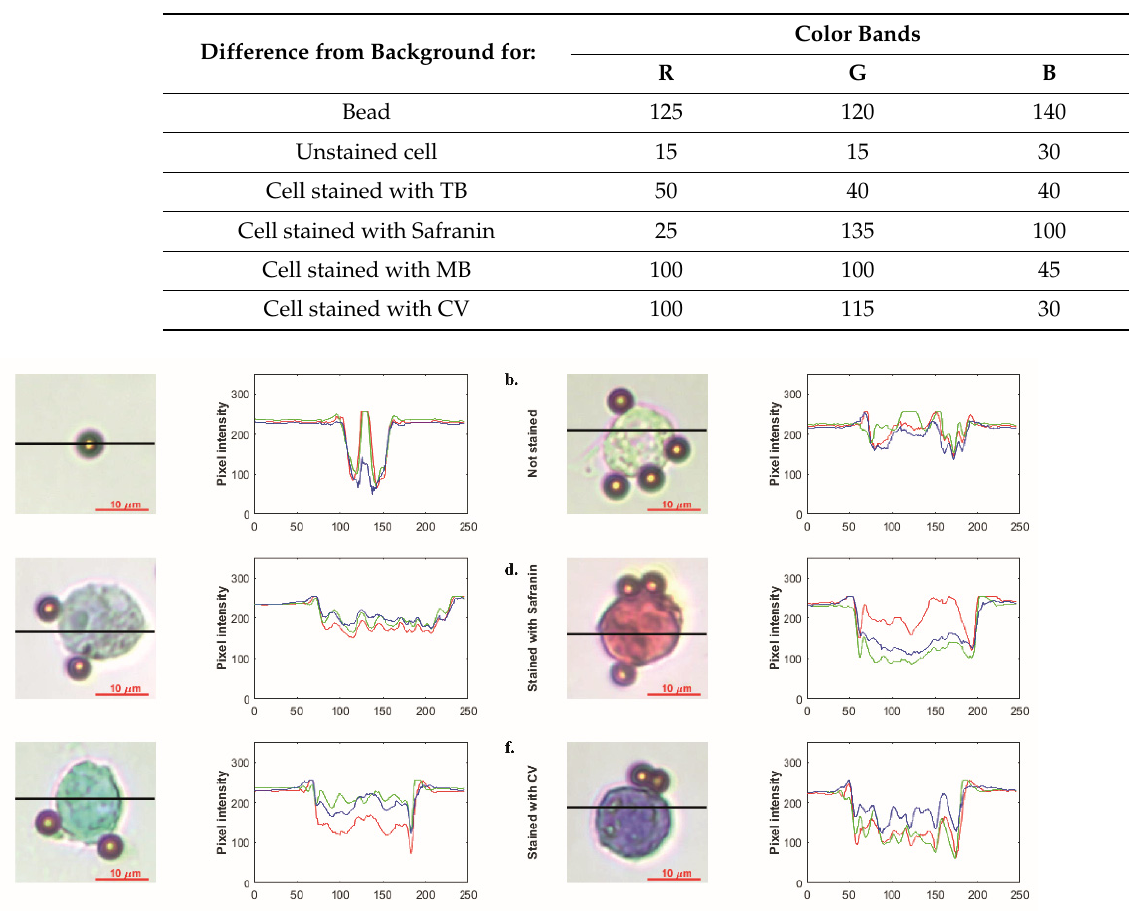
Figure 5. Microscopic images immunomagnetic bead ( a ) and single-cell unstained ( b ) and stained with simple stains such as trypan blue ( c ), safranin ( d ), methylene blue ( e ) and crystal violet ( f ), respectively. Graphics illustrate pixel intensity analysis results of related microscopic images. Images were acquired with 50 ×